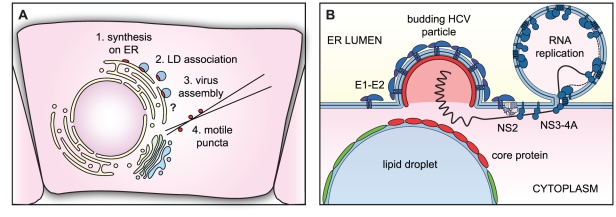
Models of core trafficking and virus assembly.(A) Our model of core protein trafficking is illustrated here. The question mark indicates that the process of virus assembly is still poorly understood. (B) Our model of virus particle assembly. Virus particle assembly likely requires the simultaneous recruitment of core protein from the surface of LDs and viral RNA from replication complexes, while nascent virus particles bud into the ER lumen. NS2 helps to coordinate this process by bringing together viral structural and NS proteins.